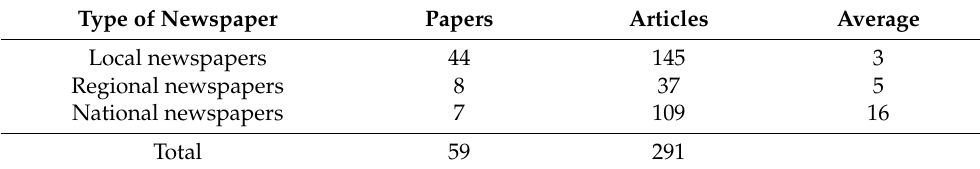
Table 3. Type of